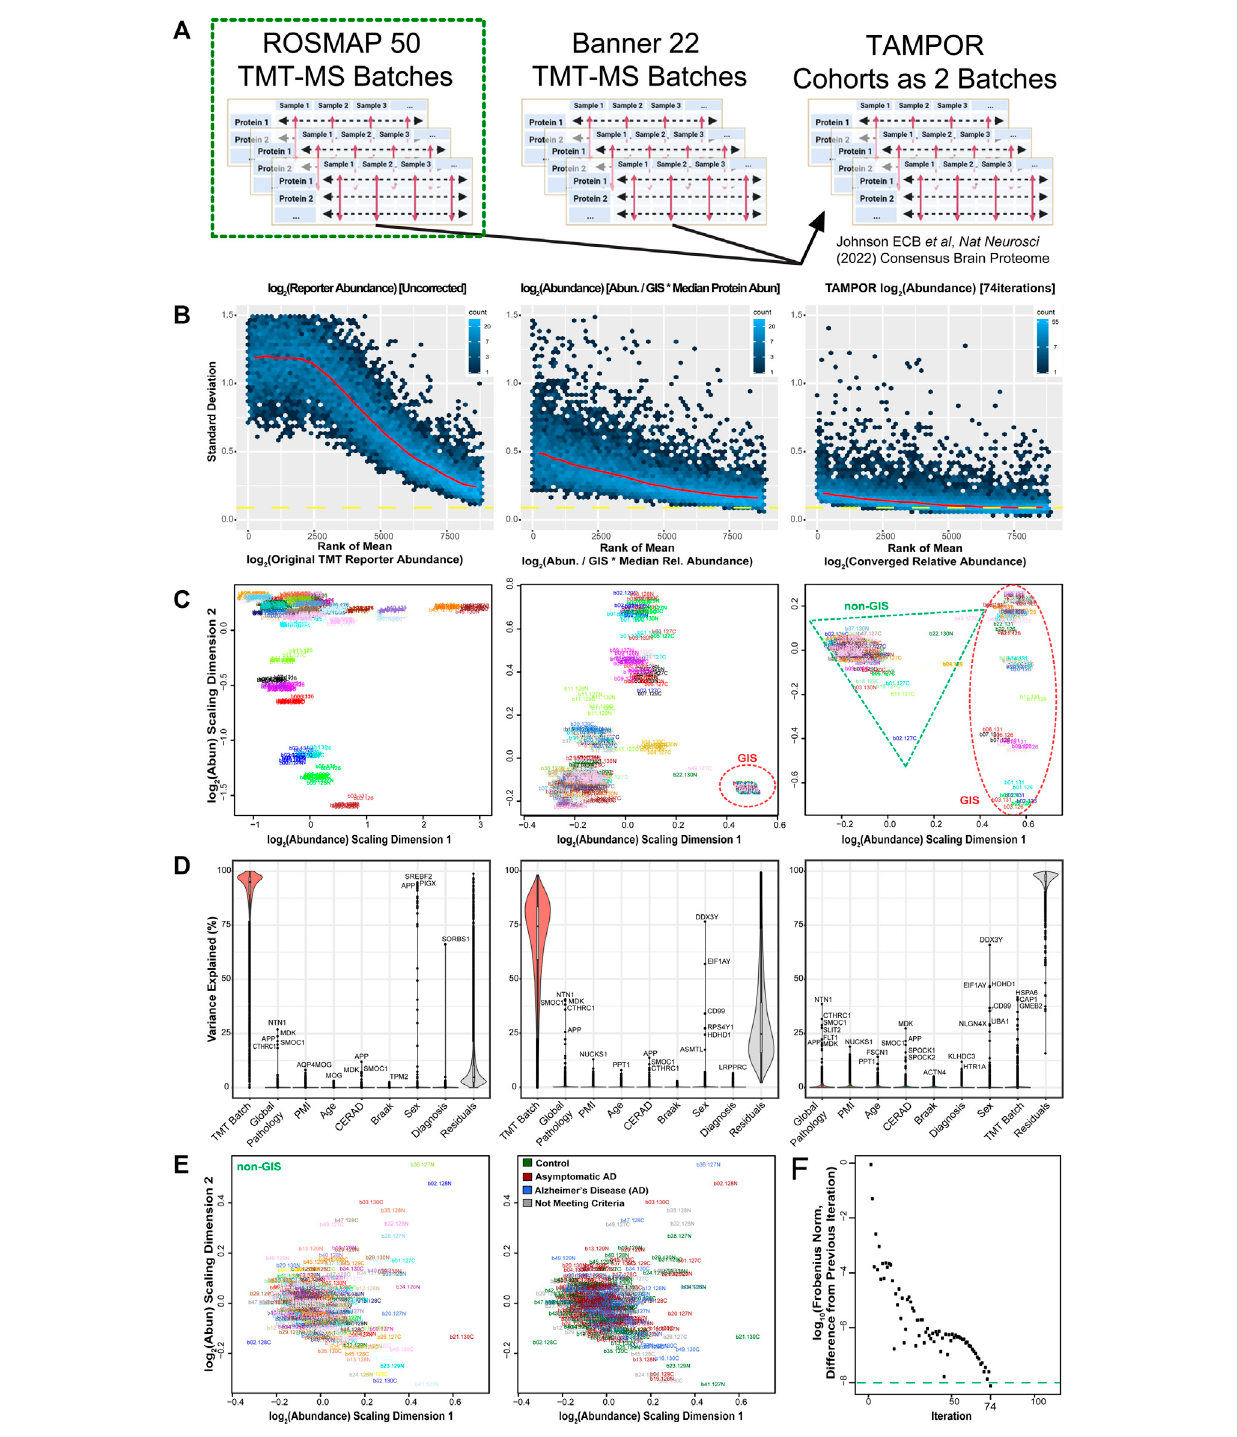
Usecase1:TAMPORcorrectionofTMT-MSdataof400frontalcortexbrainproteomeswithadefectinGIS. (A) TAMPORwasperformedsequentially ontwocohortsofTMT-MSdata, fi rsttoremoveintracohortbatcheffects,andthentoharmonizeacrossthetwocohorts,ROSMAP(50TMT-MSbatches), and Banner-SunHealth (22 TMT-MS batches). (B) Mean-SD plots of variance in original ROSMAP50 TMT log 2 abundance data for 400 case samples plus 100 GIS samples ( left ), naïve ratio-corrected log 2 abundance ( center ), and TAMPOR log 2 abundance ( right ), indicating progressive improvement in reduction of overall variance. (C) MDS plots of inter-sample variance with sample names as labels, colored by batch. Left , original ROSMAP50 TMT log 2 abundance; center , naïve ratio-corrected log 2 abundance; and right , TAMPOR log 2 abundance. GIS sample cluster(s) are circled in the center and right panels with a red dashed ellipse. Non-GIS samples are within the green dashed triangle on the right. (D) Variance partitioning violin plots indicating median variance explained by each variable, with the top proteins for clinical, pathological, and demographic variables speci fi ed. Left ,